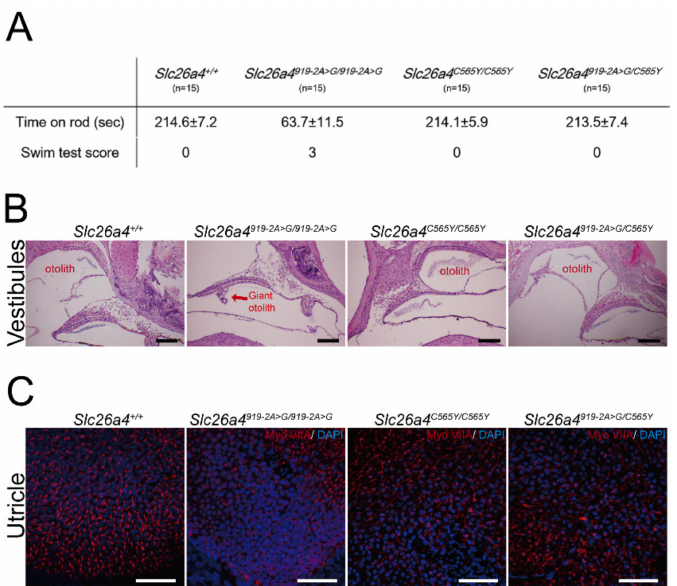
Figure 3. Vestibular phenotypes and histology of vestibular organs. ( A ) In contrast to Slc26a4 919-2A>G/919-2A>G mice, homozygous Slc26a4 C565Y/C565Y mice and compound heterozy- gous Slc26a4 919-2A>G/C565Y mice performed well in swimming and rotarod tests, similar to wild-type Slc26a4 +/+ mice. ( B ) Histology of vestibular organs. Giant otoconia ob- served in Slc26a4 919-2A>G/919-2A>G mice, but was normal in Slc26a4 +/+ , Slc26a4 C565Y/C565Y , and Slc26a4 919-2A>G/C565Y mice (bar = 150 µ m). ( C ) Fluorescence confocal microscopy. In